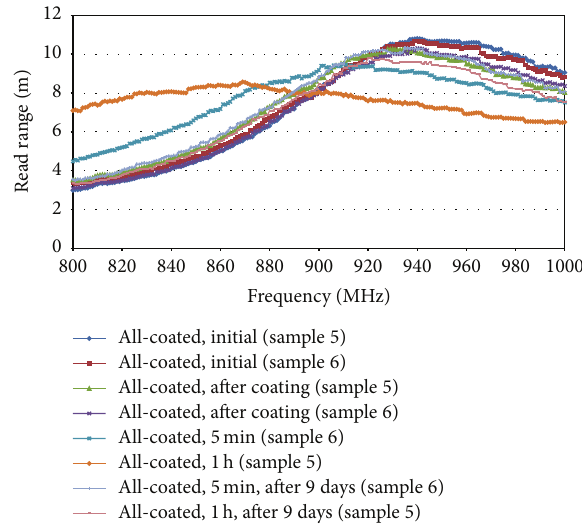
Figure 5: Measurement results for all-coated sensor